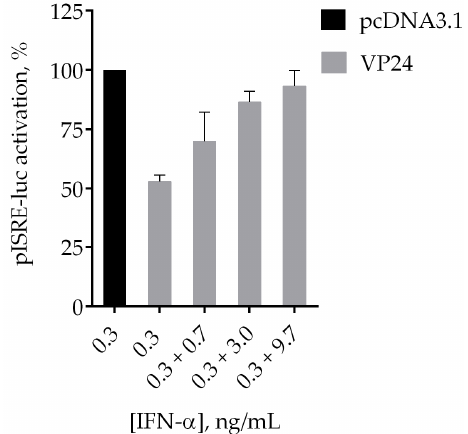
Figure 7. Effect of IFN ‐α on VP24 inhibition of IFN signaling. HEK293T cells were cotransfected with pISRE ‐ luc (60 ng/well), RL ‐ TK (10 ng/well), and pcDNA3.1 or VP24 expression plasmid (30 ng/well). Twenty ‐ four hours after transfection, cells were stimulated with 0.3 ng/mL of IFN ‐α . Then, increasing concentrations of IFN ‐α were added. After 8 h of stimulation, the medium was changed and luciferase activity was measured. Results are shown as percentage of ISRE expression in VP24 transfected cells over empty vector transfected control. Firefly luciferase activity is normalized to the Renilla luciferase internal control. Error bars indicate the mean ± SD.